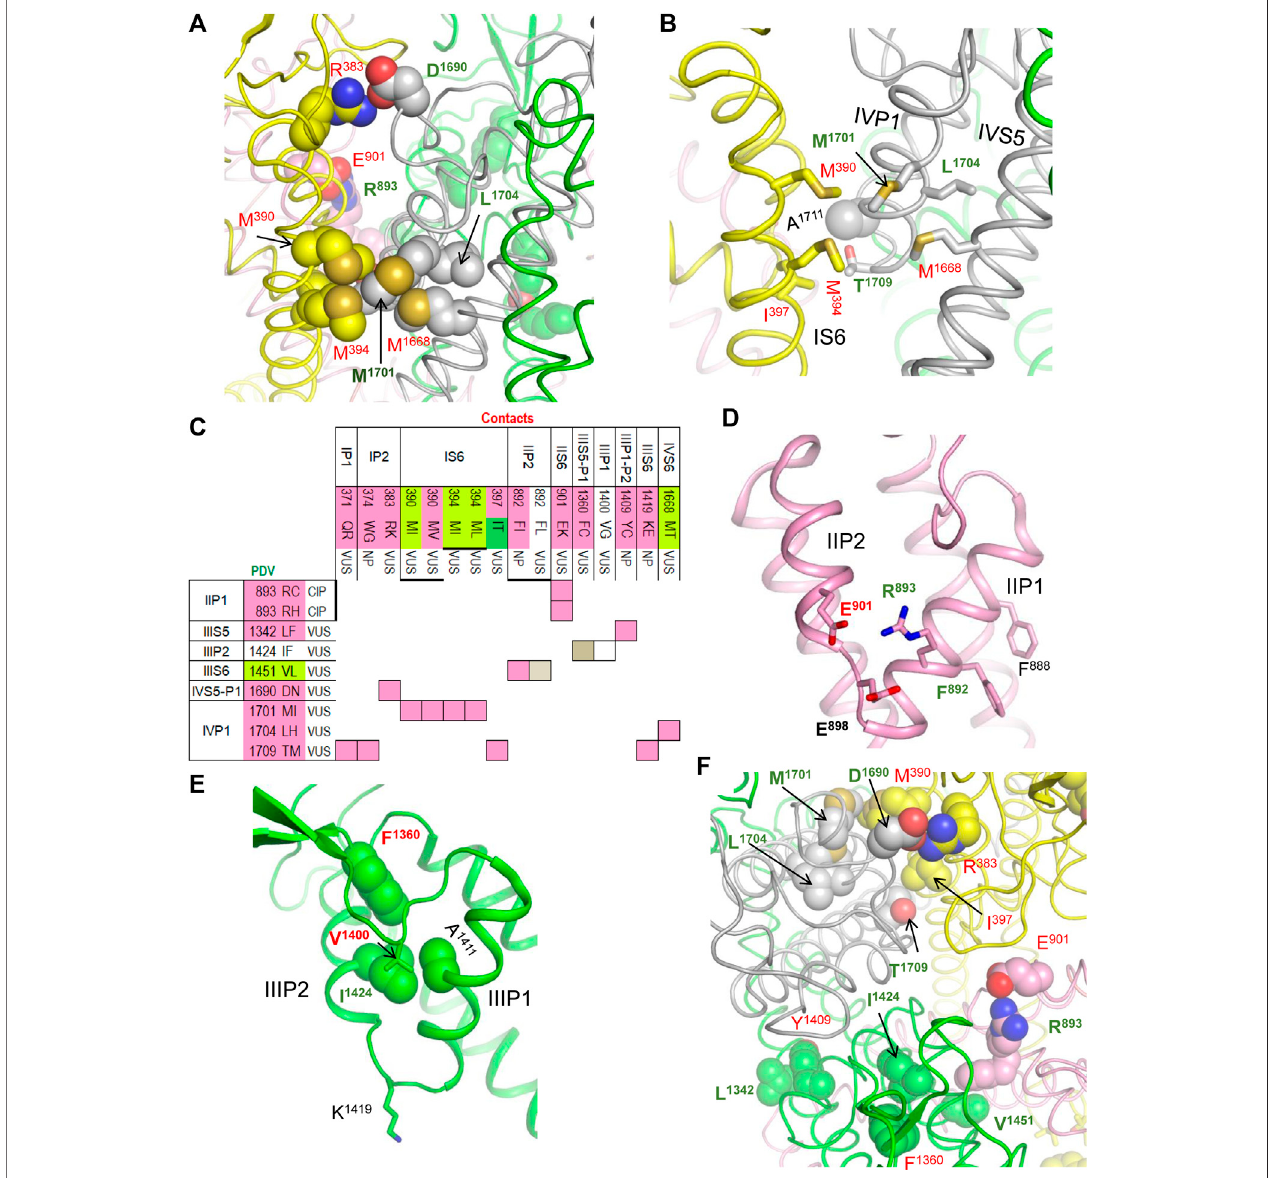
FIGURE 2 | Residue contacts that stabilize P-loops in the cryo-EM structure. Backbones and sidechain carbon atoms in repeats I, II, III and IV are yellow, pink, green and gray, respectively. Residues w54 and their contacts are indicated with green and red labels, respectively. (A,B) Intra-membrane views of P-loops in the cryo- EMstructure.ResiduesM 390 ,M 394 ,M 1668 ,M 1701 andL 1704 formatighthydrophobiccluster,whichapparentlystabilizesmutualdispositionofhelicesIS6,IVS5andIVP1. (C) Matrix of contact variants in P-loops. Majority of coupled variants are associated with BrS1 and arrhythmia, which also may be a loss-of-function disease. (D) Intra-membrane view of helices IIP1 and IIP2 whose mutual disposition is stabilized by salt bridge R 893 :E 901 . Side-chain conformation of the selectivity- fi lter DEKA glutamateE 901 isstabilizedbyitssaltbridgewithR 898 .HelicalstructureofhelixIIP1isstabilizedby π -stackingF 888 andF 892 . (E) Intra-membraneviewofhelicesIIIP1and IIIP2 whose mutual disposition is stabilized by a cluster of four hydrophobic residues. The selectivity- fi lter DEKA lysine K 1419 is shown by sticks. (F) Extracellular view of salt bridges R 383 :D 1690 , R 893 :E 901 and hydrophobic contacts I 397 :T1 709 , L 1342 :Y 1409 and I 1424 :F 1360 .